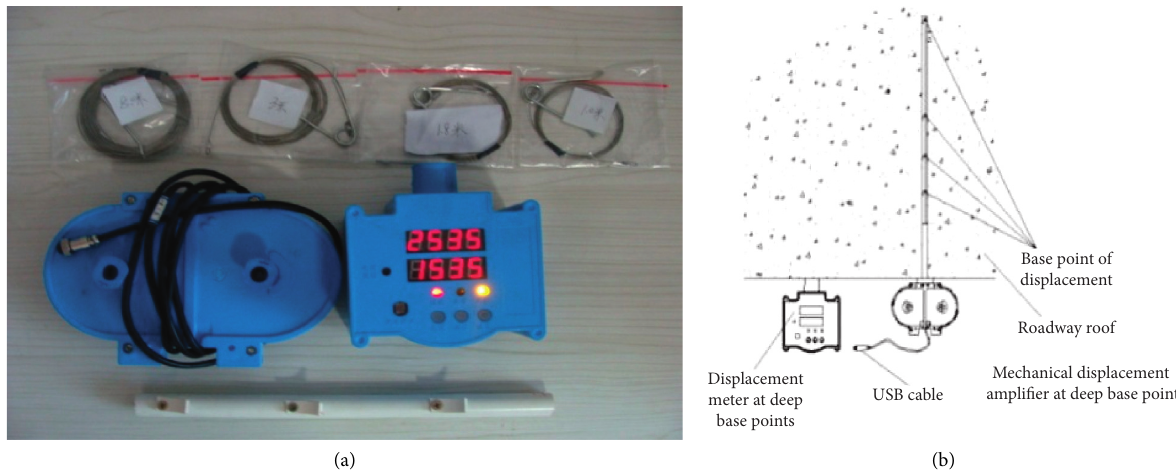
Figure 18: A monitoring system for deep displacement at multiple base